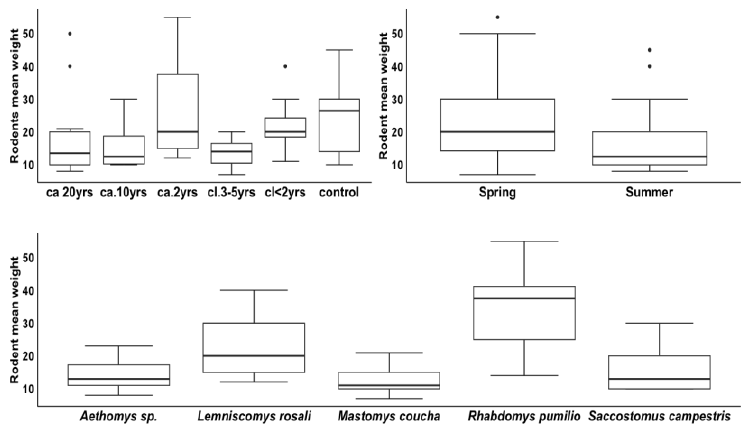
Figure 9. The median weight of rodents by treatments, season, and species inside the Groenkloof Nature Reserve. ( Lantana camara invasion durations ( ca ), differing Lantana camara clearing ( cl ) times, and a control area without Lantana camara invasion inside the Groenkloof Nature Reserve, South Africa). Dots outside the boxes represent outliers.